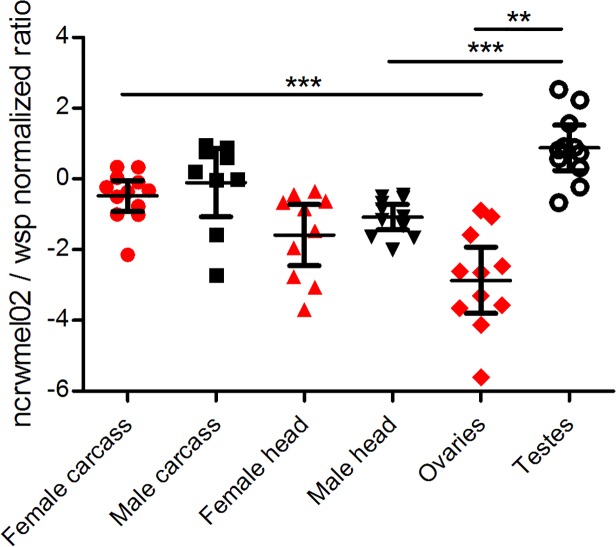
Expression of ncrwmel02 in the wMel strain from gonads, heads and carcasses of 1-day-old male (black) or female (red) D. melanogaster.Expression (mean ± 95% CI) normalized to wsp expression (Mann-Whitney U test, ** p < 0.01 *** p < 0.001)